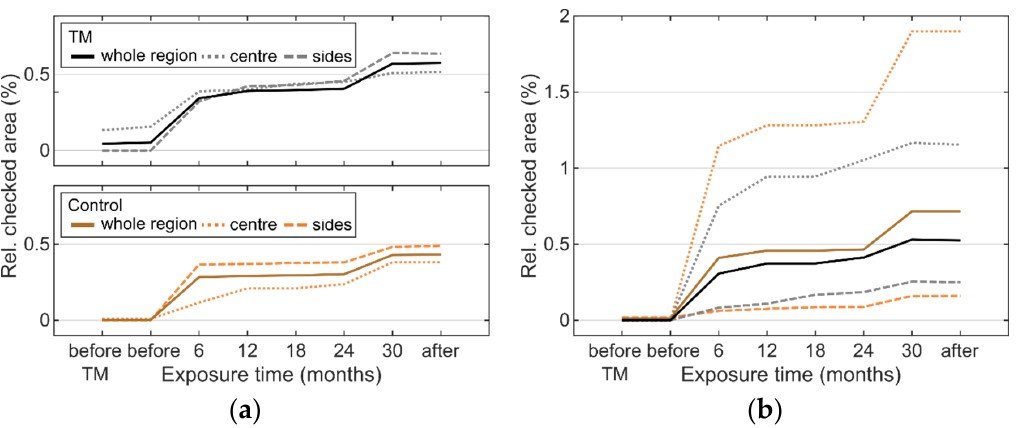
Figure 5. Mean relative area of surface checks (% of total investigated area) from digital image processing of ‘exposed’ control and TM boards by exposure time: ( a ) pith side (group 1: pith up) and ( b ) bark side (group 2: bark up) [legend in a ].